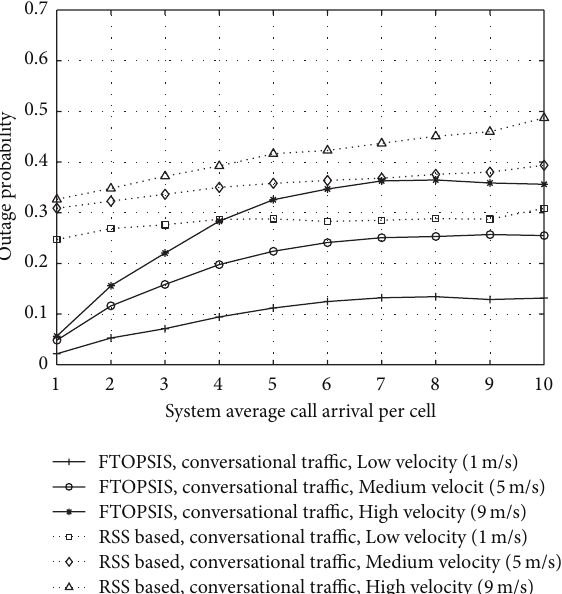
Figure 9: Handoff rate using TOPSIS-FAHP.